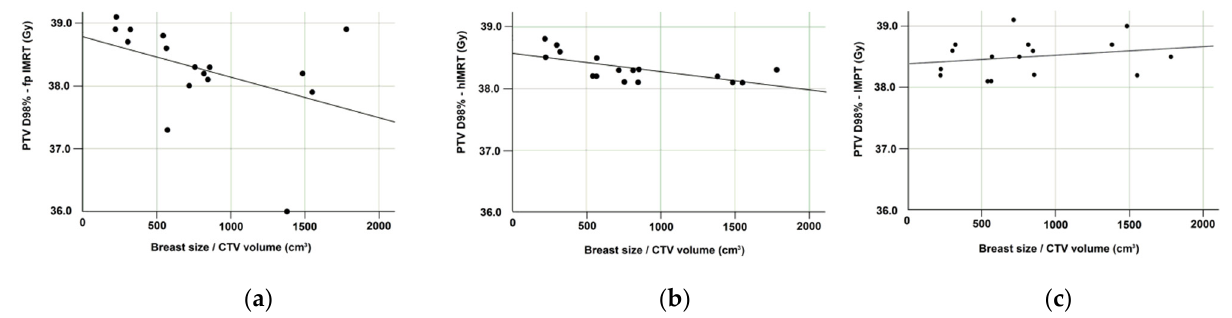
Figure 2. Correlation between breast size and PTV minimum dose (D98%) for: ( a ) fp-IMRT; ( b ) h-IMRT; ( c ) IMPT plans. All n = 16. Abbreviations: fp-IMRT—forward planned intensity-modulated radiation therapy; h-IMRT—hybrid intensity- modulated radiation therapy; IMPT—intensity modulated proton therapy.